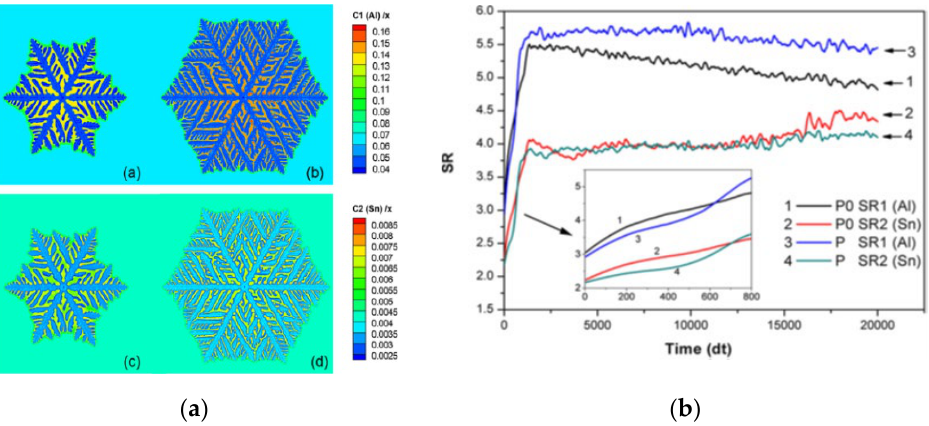
Figure 3. ( a ) the solute distribution of Al and Sn under ambient pressure P0 and applied pressure P, and ( b ) the evolution of micro segregation ratio under P0 and P [77].